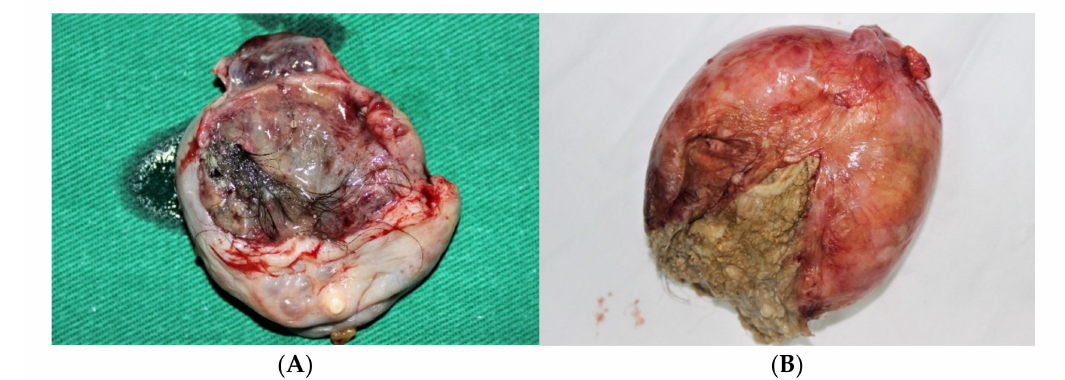
Figure 5. Mature cystic teratoma of the ovary ( A , B ). (Courtesy of Prof. G. Peltecu). Teeth are identified in 30% of cases, while bone, cartilage, adipose tissue, or brain tissue, are even rarer. Completely solid mature (benign) teratomas are very rare. Extensive solid and dense regions are unusual in a benign cystic teratoma and they should prompt careful sampling for histologic study to exclude malignancy [29].